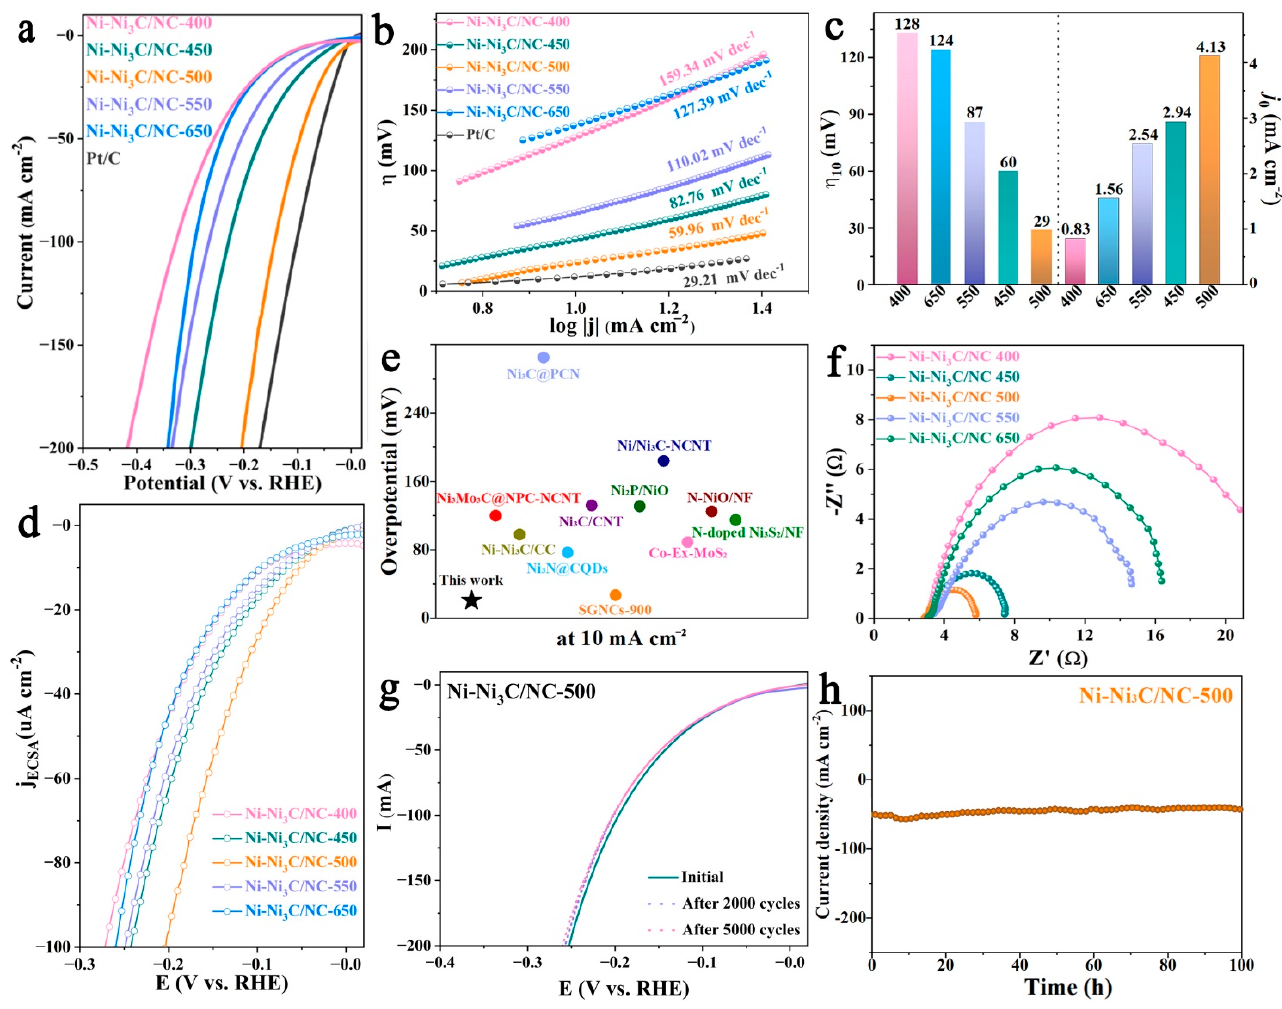
Figure 3. Electrochemical Property of Ni-Ni 3 C/NC for HER. ( a ) Polarization curves of various Ni-Ni 3 C/NC and Pt/C in 1.0 M KOH. ( b ) Tafel plots obtained from the polarization curves in ( a ). ( c ) Overpotentials at 10 mA cm − 2 (left) and exchange current densities (right). ( d ) ECSA-normalized LSV curves of various Ni-Ni 3 C/NC. ( e ) The comparison of HER overpotentials at 10 mA cm − 2 for different catalysts. ( f ) The EIS plots of Ni-Ni 3 C/NC measured at an overpotential of 150 mV ( g ) Polarization curves before and after 2000 and 5000 CV cycles of Ni-Ni 3 C/NC-500. ( h ) A long-term current stability measurement of Ni-Ni 3 C/NC-500 at a − 0.2 V overpotential for 100 h.